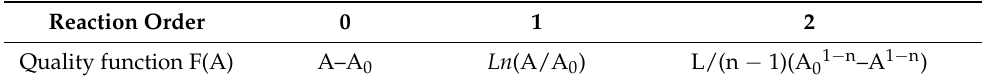
Table 2. Expression of quality function under different reaction orders. Reaction Order 0 1 2 Quality function F(A)